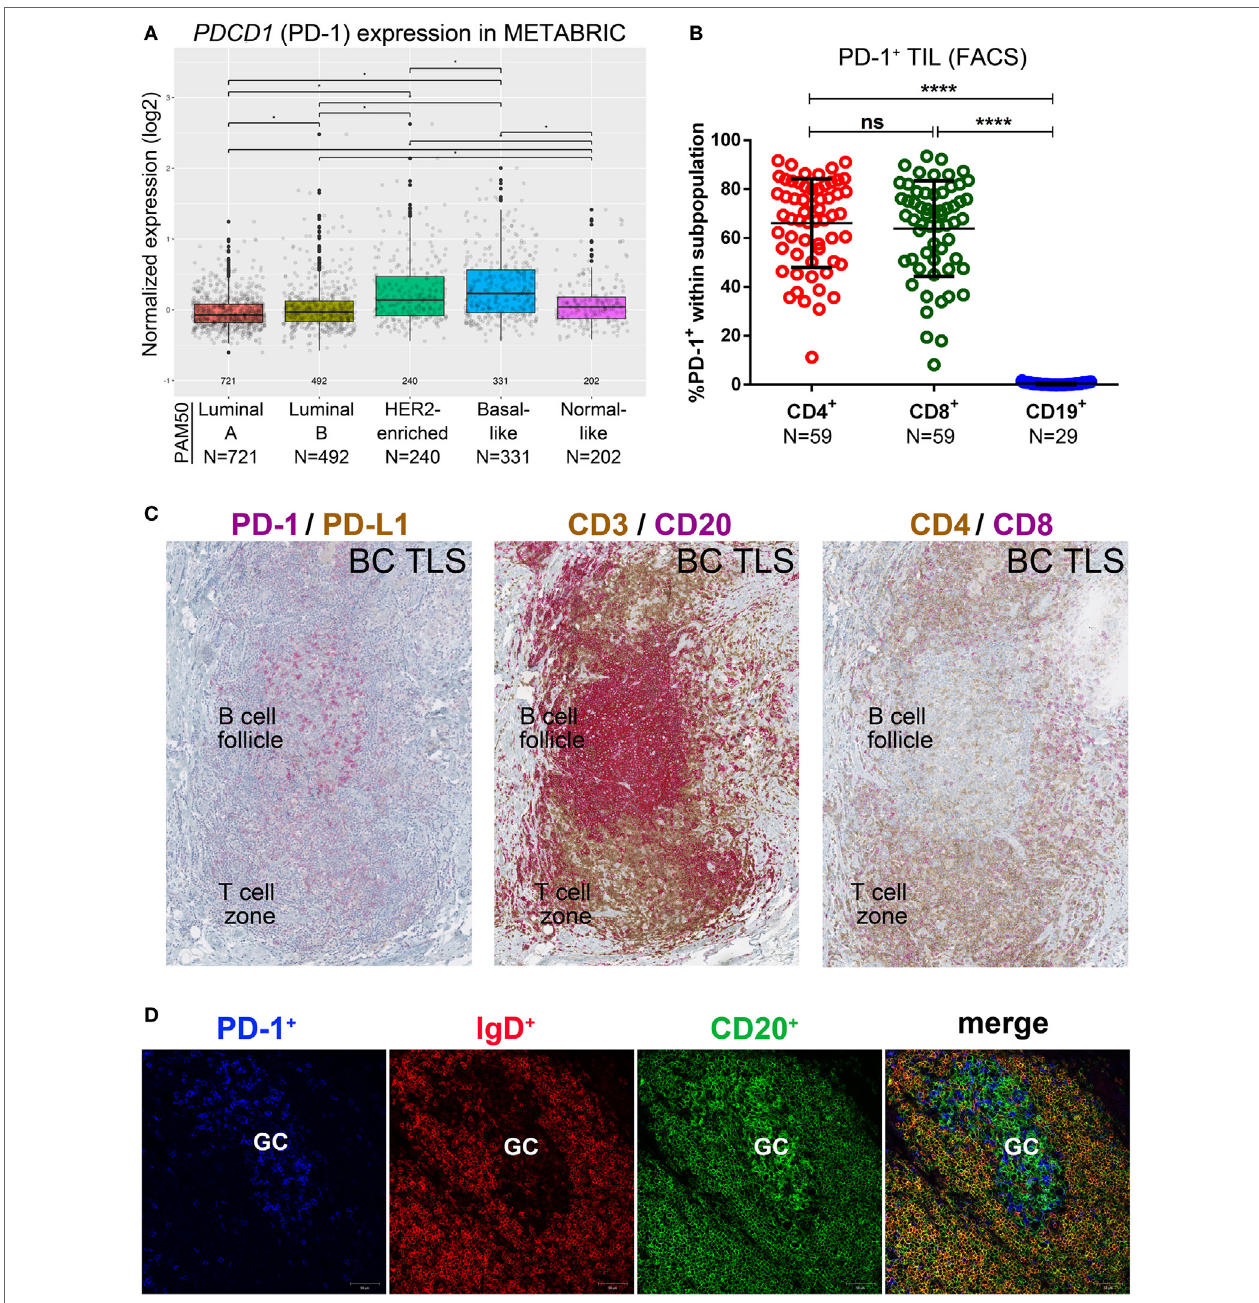
FigUre 1 | PD-1 expression in primary breast cancer (BC). (a) Expression of the PDCD1 gene in BC by PAM50 molecular subtypes (microarray data from the METABRIC dataset) (37). Box plots show median ± interquartile range related to log of expression of each gene by different subtypes (Luminal A, Luminal B, HER2-enriched, Basal-like and Normal-like). (B) PD-1 expression by the major subsets (CD4 + , CD8 + , and CD19 + ) of tumor-infiltrating lymphocytes (TIL) isolated from fresh primary breast tumors analyzed by FACS. Bars show mean ± SD. The number of samples included ( N ) is based on the tumor homogenate having a threshold minimum number of TIL for analysis. (c) Expression of PD-1 and PD-L1 by immunohistochemistry in BC-associated tertiary lymphoid structures (TLS) stained with dual CD3/CD20, CD4/CD8, and PD-L1/PD-1 labeling. In brown: CD3, CD4 and PD-L1; in red: CD20, CD8 and PD-1. (D) Expression of PD-1, IgD, and CD20 by immunofluorescence in the germinal center (GC) of a BC associated TLS. In blue: PD-1, in red: IgD, in green CD20.